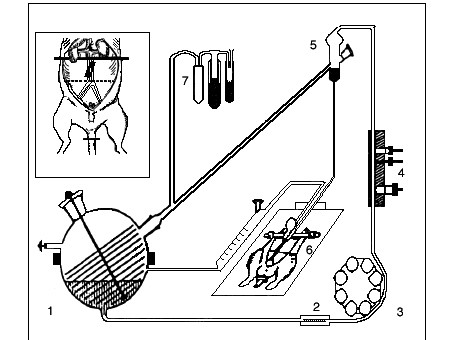
A: Isolated rat hindquarter preparation. The perfused muscle mass is below the dotted line. The tail is clamped off. B: Recirculating perfusion system. Heart piece is the oxygenator (1), wherein the medium is gassed (95% O2, 5% CO2) and from where it is pumped (3) up via a filter (nylon mash, 20 μm width) (2) and pH and pO2 probes (4) to attain hydrostatic pressure of 80 mm Hg (5) before entering the hindquarter (6). Intermediate sampling and pH adjustment can be carried out if necessary (7).